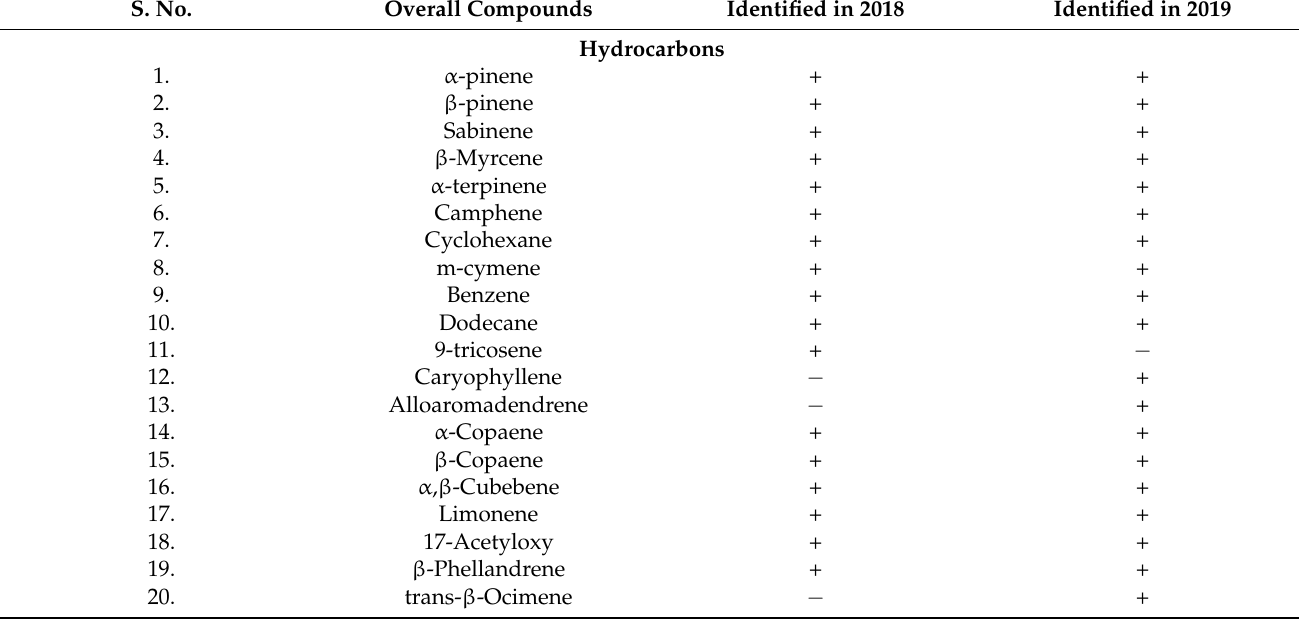
Table 1. Overall compounds identified in pomelo juice extracts harvested in 2018 and 2019. S.